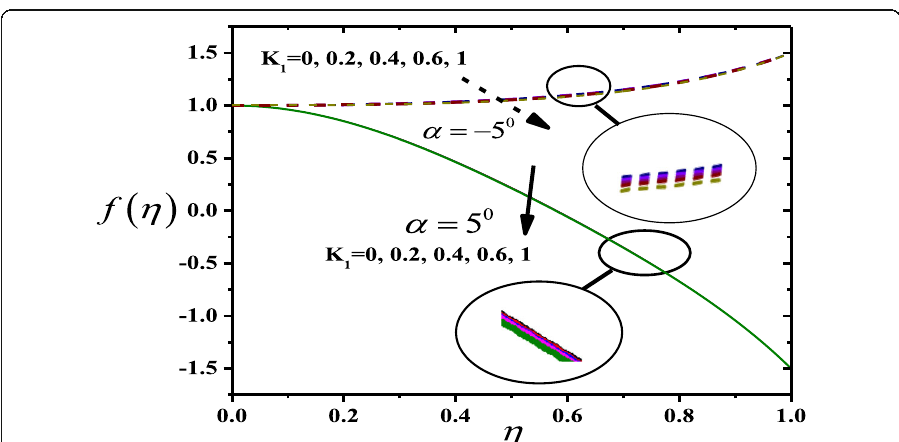
Fig. 7 Velocity vs. K 1 in shrinking divergent and stretching convergent